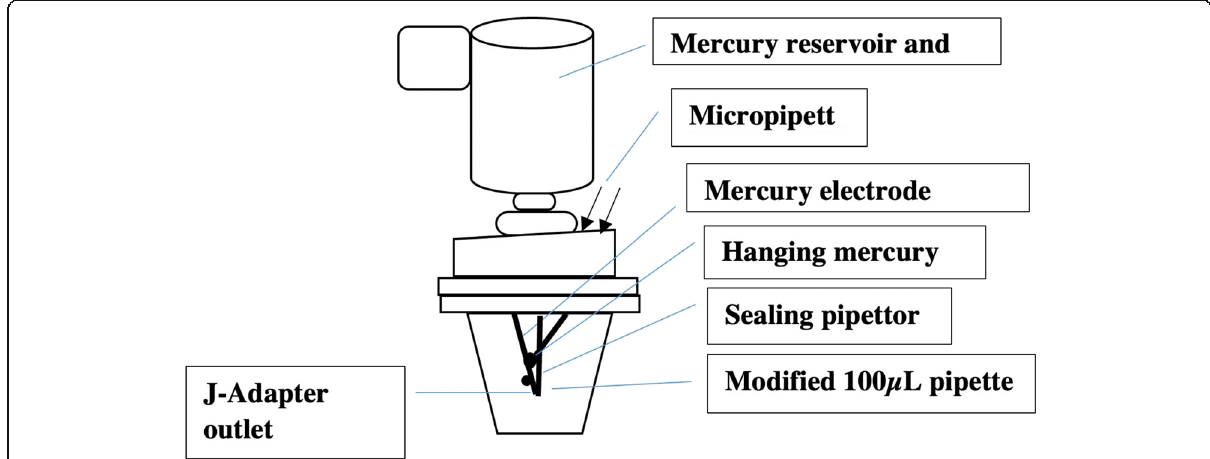
Fig. 5 Diagram metric demonstration of electrochemical cell for gunshot residue particle analysis using ASV